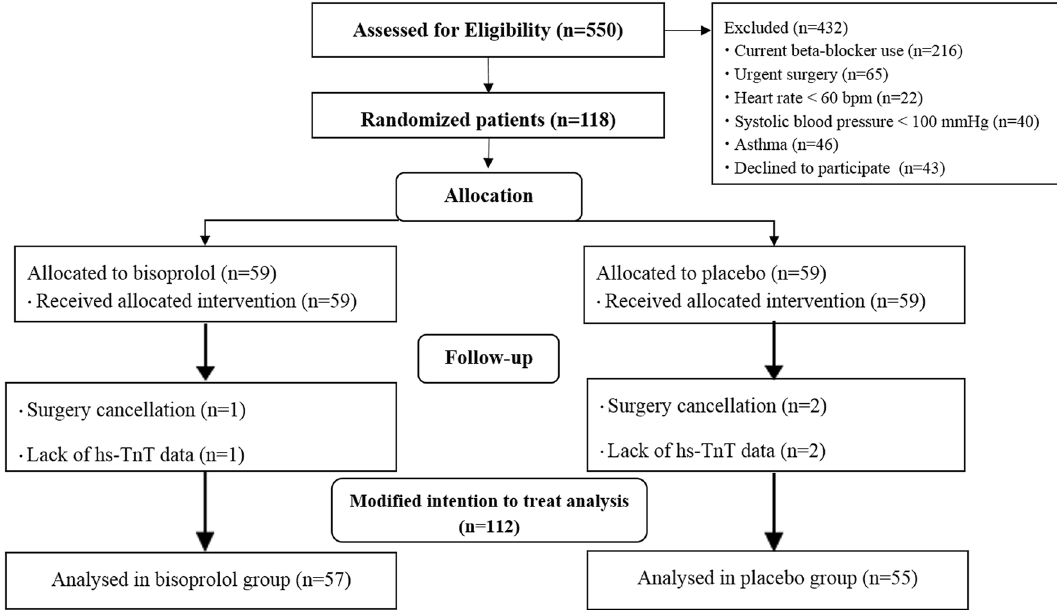
Figure 1. CONSORT flow diagram of randomized